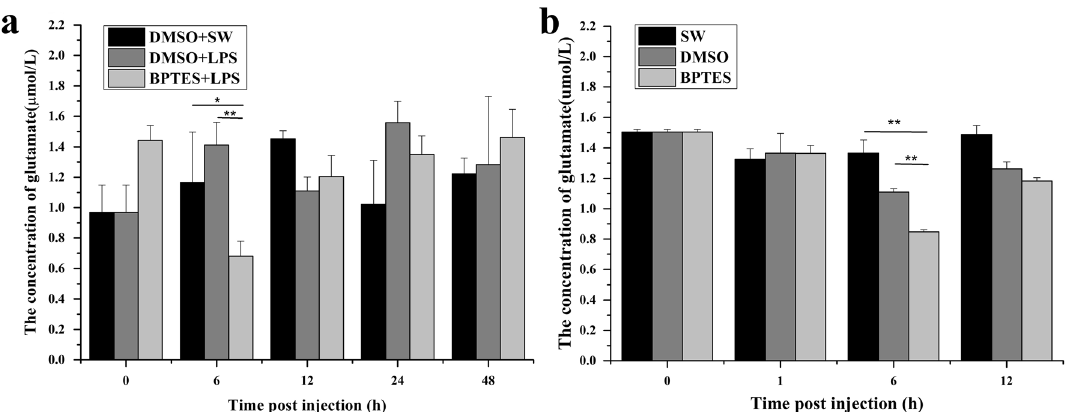
Figure 4. The content of Glu in serum of oysters after BPTES and LPS treatments. ( a ) The content of Glu after BPTES injection. ( b ) The content of Glu after BPTES and LPS stimulation. Vertical bars represent the mean ± S.D. (N = 3). Asterisks indicate significant differences. (* p < 0.05; ** p <